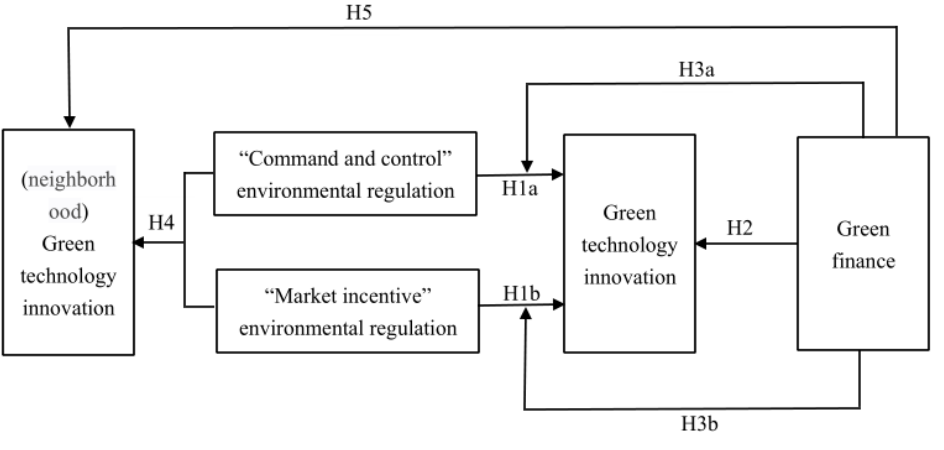
Figure 1. Conceptual